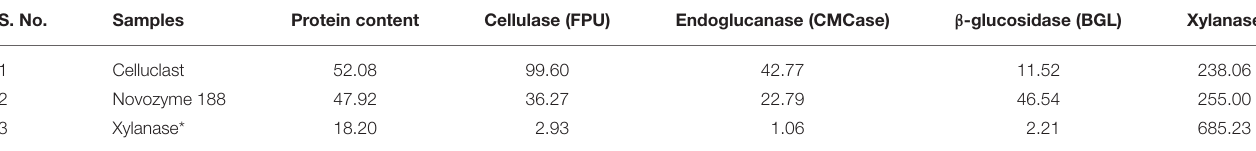
TABLE 1 | Analysis of commercial enzyme preparations. S.